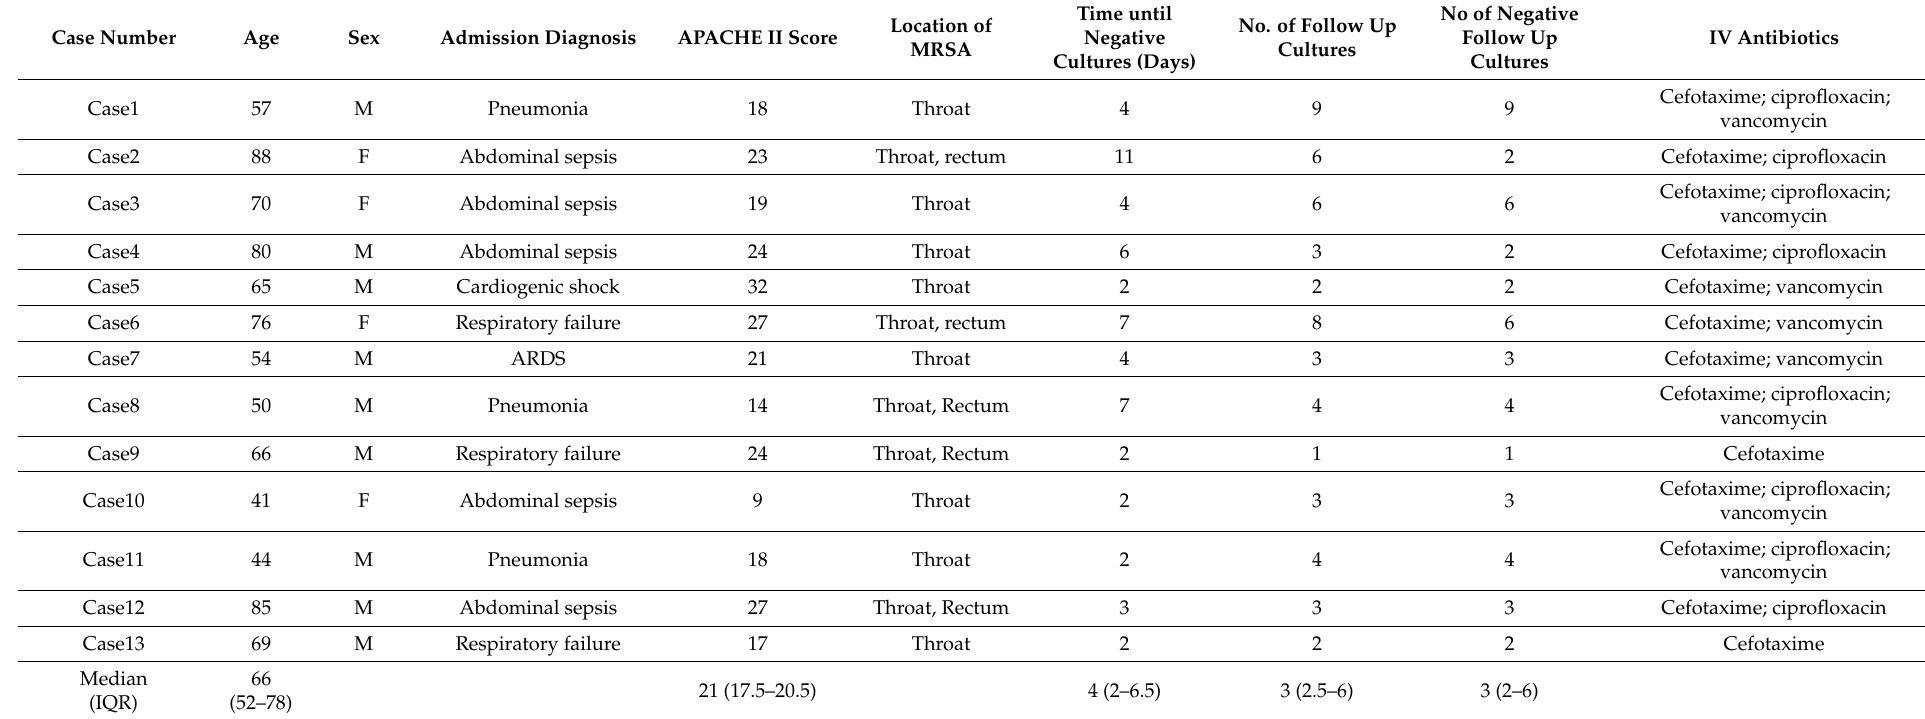
Table 1. Baseline characteristics, MRSA location and results of follow-up cultures per